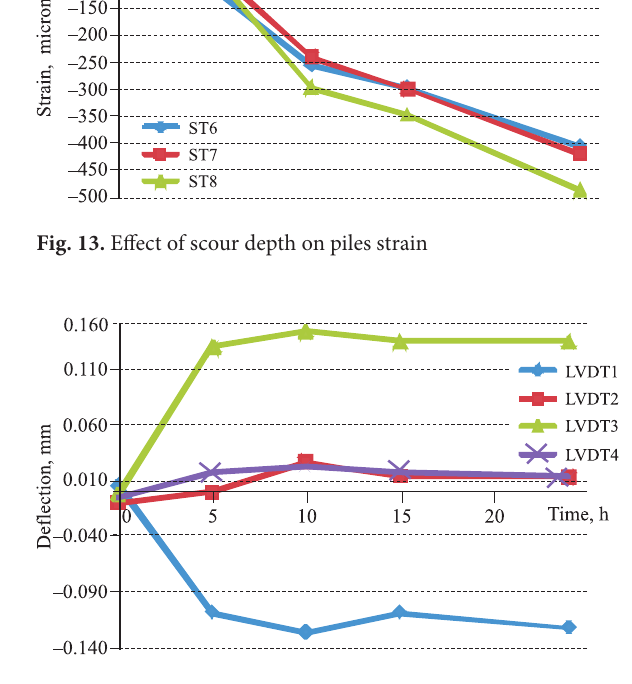
Fig. 14. Effect of scour depth on slab deflection